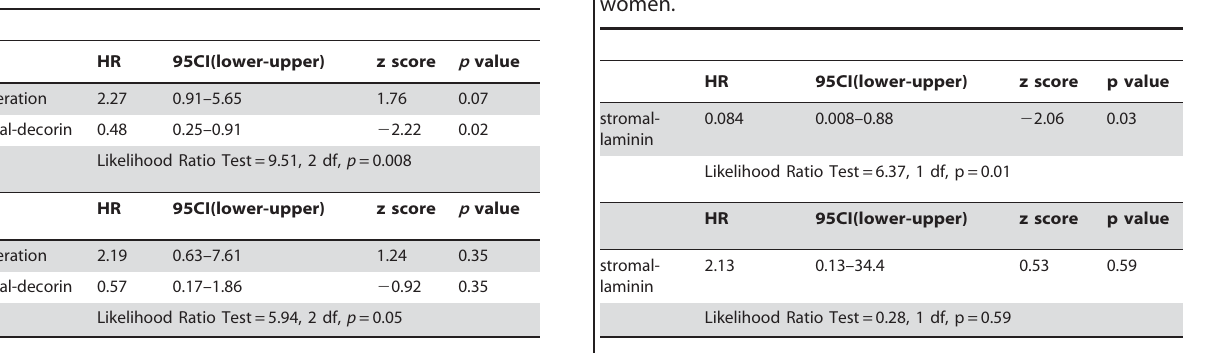
Table 9. Cox proportional hazards models for UPPSALA estrogen receptor-positive older ( . 60) and younger ( , 60) women.